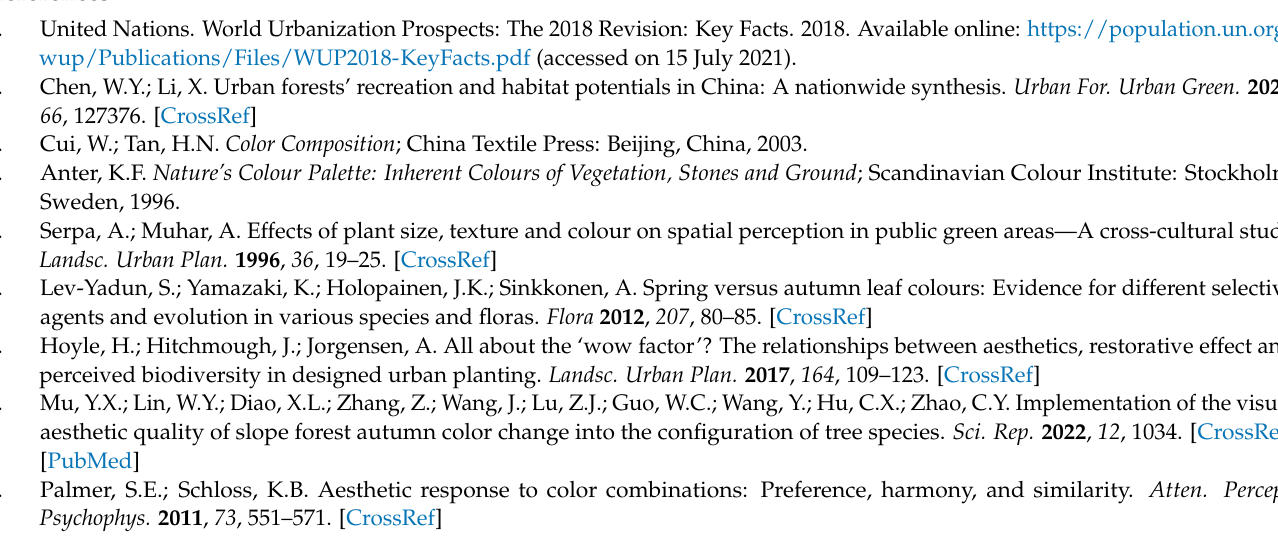
the metrics were calculated photograph by photograph.